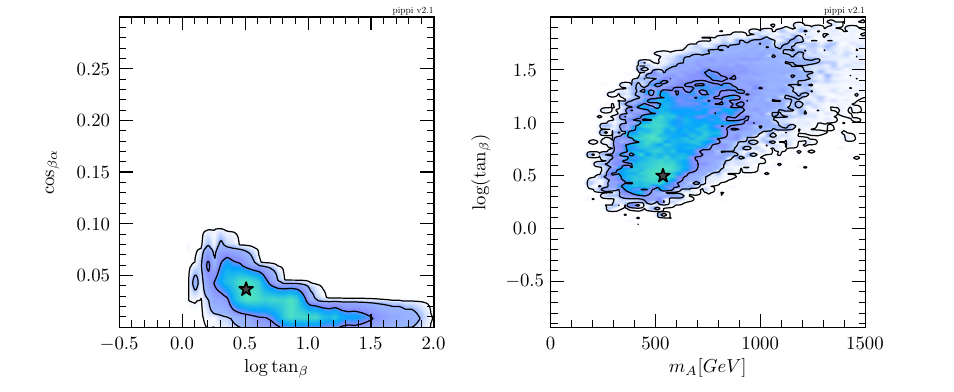
Figure 5. 2D profile likelihood distributions with all constraints switched on in the planes c βα vs t β (left) and m A , pole vs t β (right) . The solid lines represent 1 , 2 and 3 σ regions and the best-fit points are plotted as black